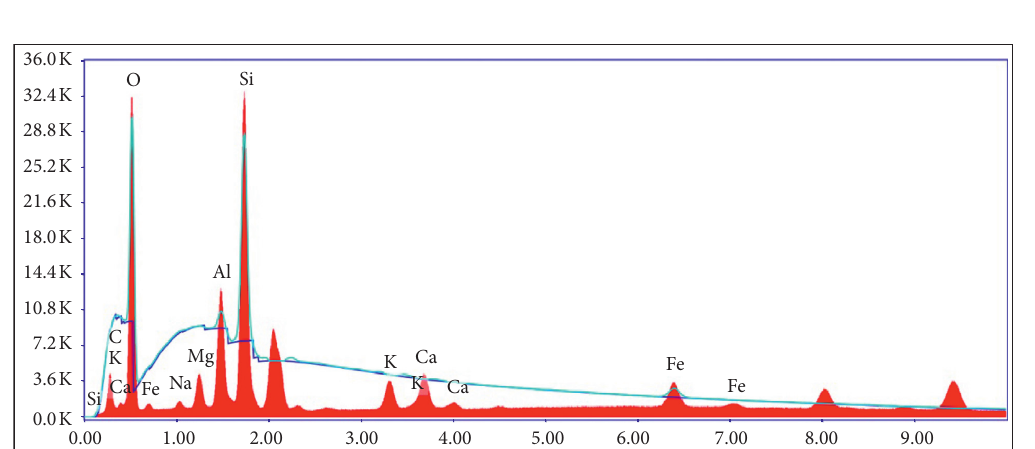
Figure 3: XRD results [6].